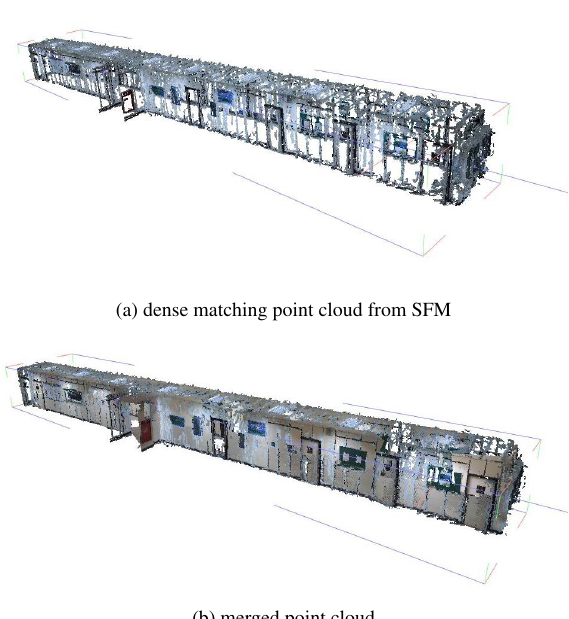
Figure 4: Comparison of original dense matching and merged point clouds